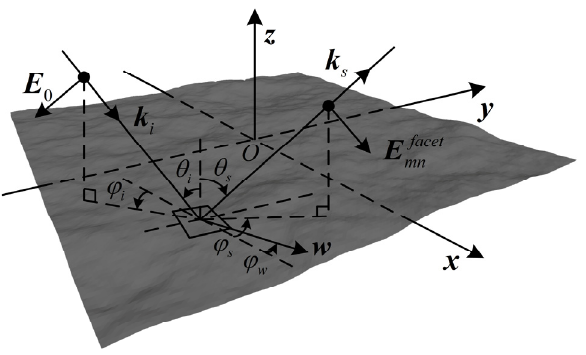
Figure 1. The geometry of the bistatic scattering from ocean surface.